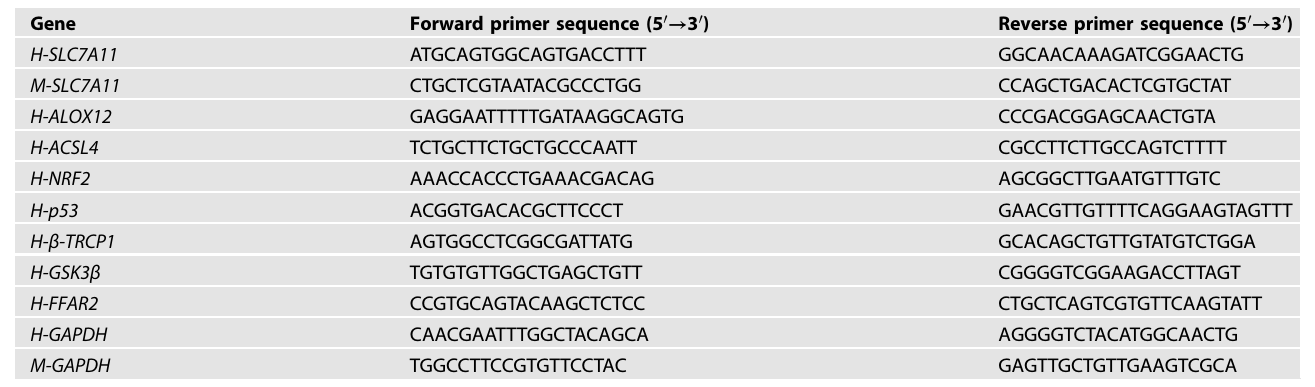
Table 1. Primer sequences for